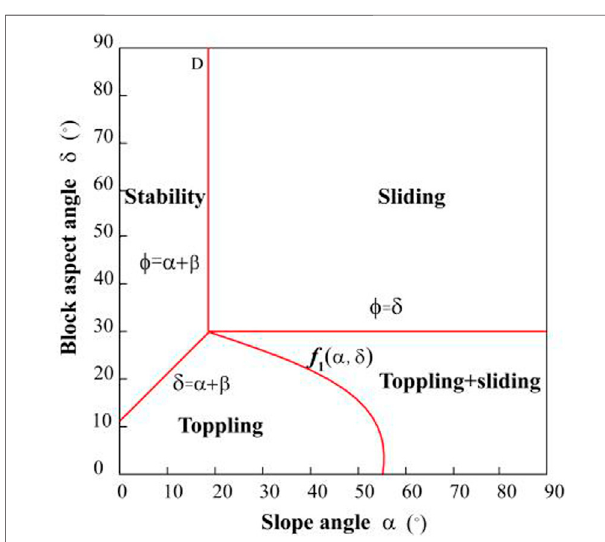
FIGURE4| Boundaryofsingleblockstateunderhorizontalseismicload ( ϕ (cid:1) 30 ° ) .